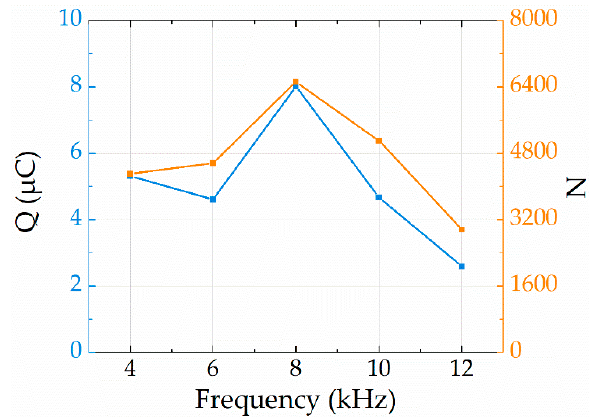
Figure 12. PD number and magnitude at different frequencies in test.